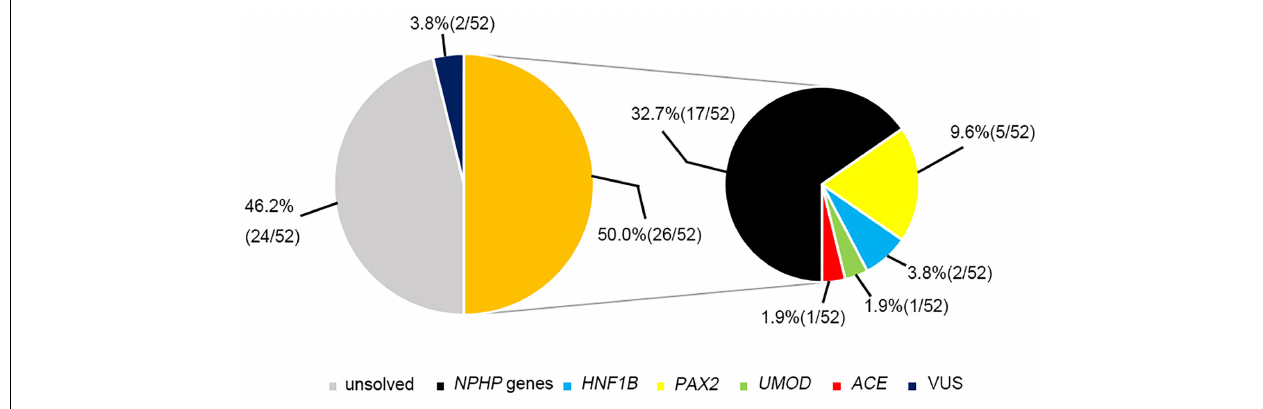
FIGURE 4 | The genetic examination results for 52 patients who were highly suspected of having